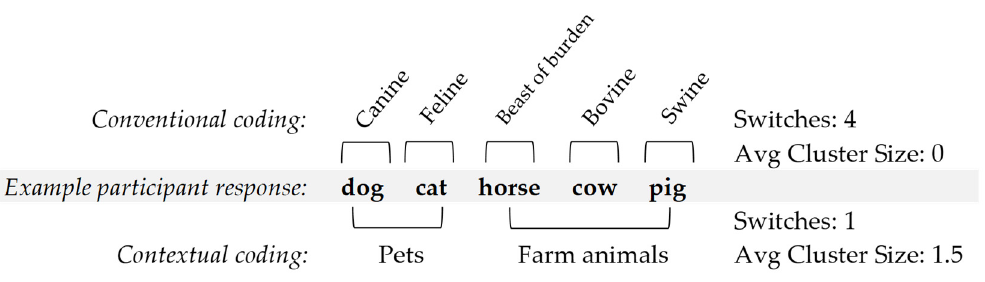
Figure 1. Conventional and contextual coding example. Note: As pets form a cluster of 1 and farm animals a cluster of 2, the average cluster size is 1.5.